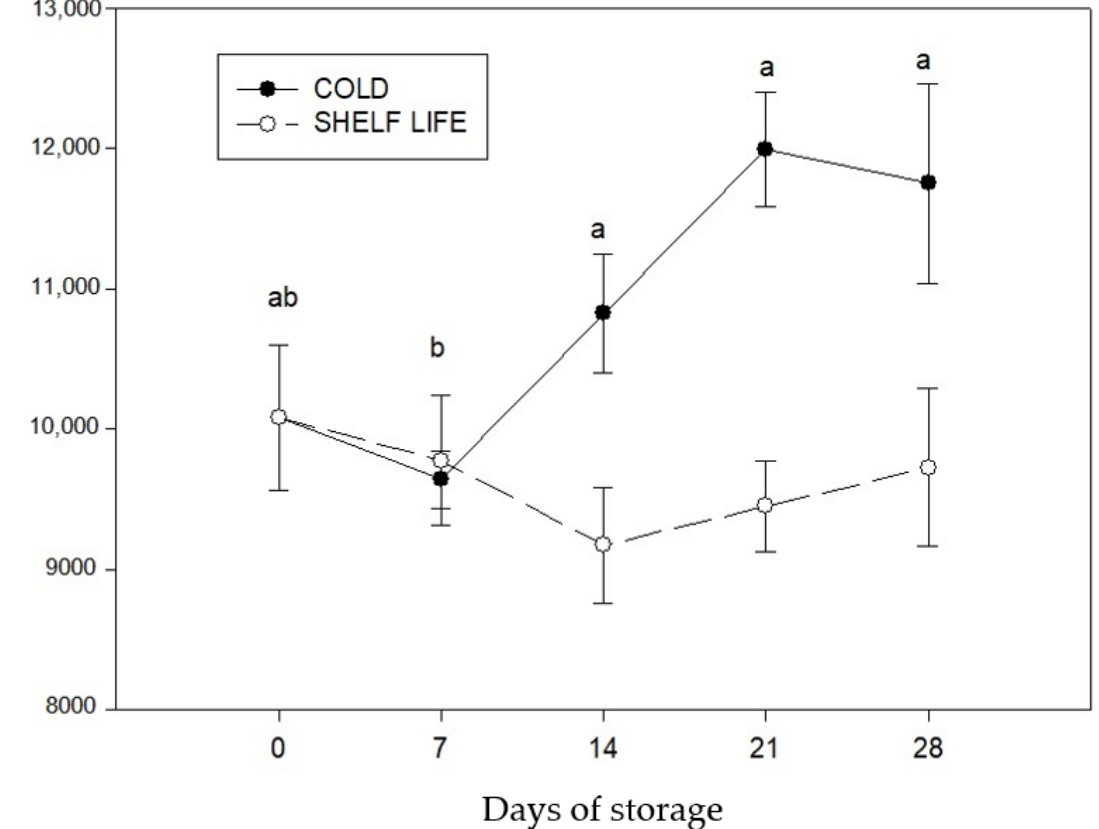
Figure 2. Changes in respiration rate (CO 2 ) (a) and ethylene concentration (b) in cactus pear fruit during storage under cold and shelf life conditions. Data are the mean ± SE ( n = 6). Tukey’s test at a 95% confidence level is shown. Different letters indicate significant differences ( p < 0.05) during each storage